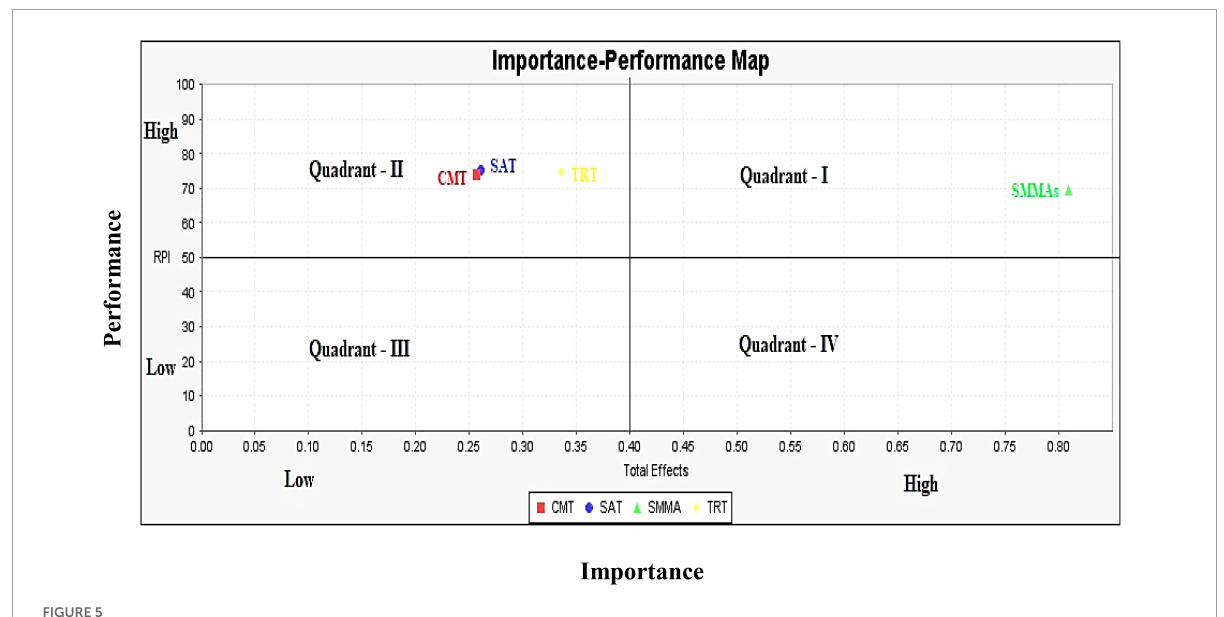
FIGURE5 IPMA performance and importance